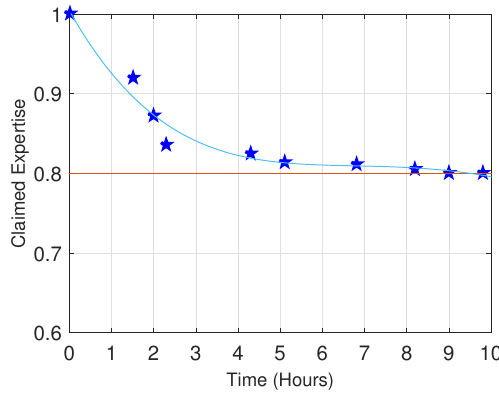
Figure 6. Convergence of